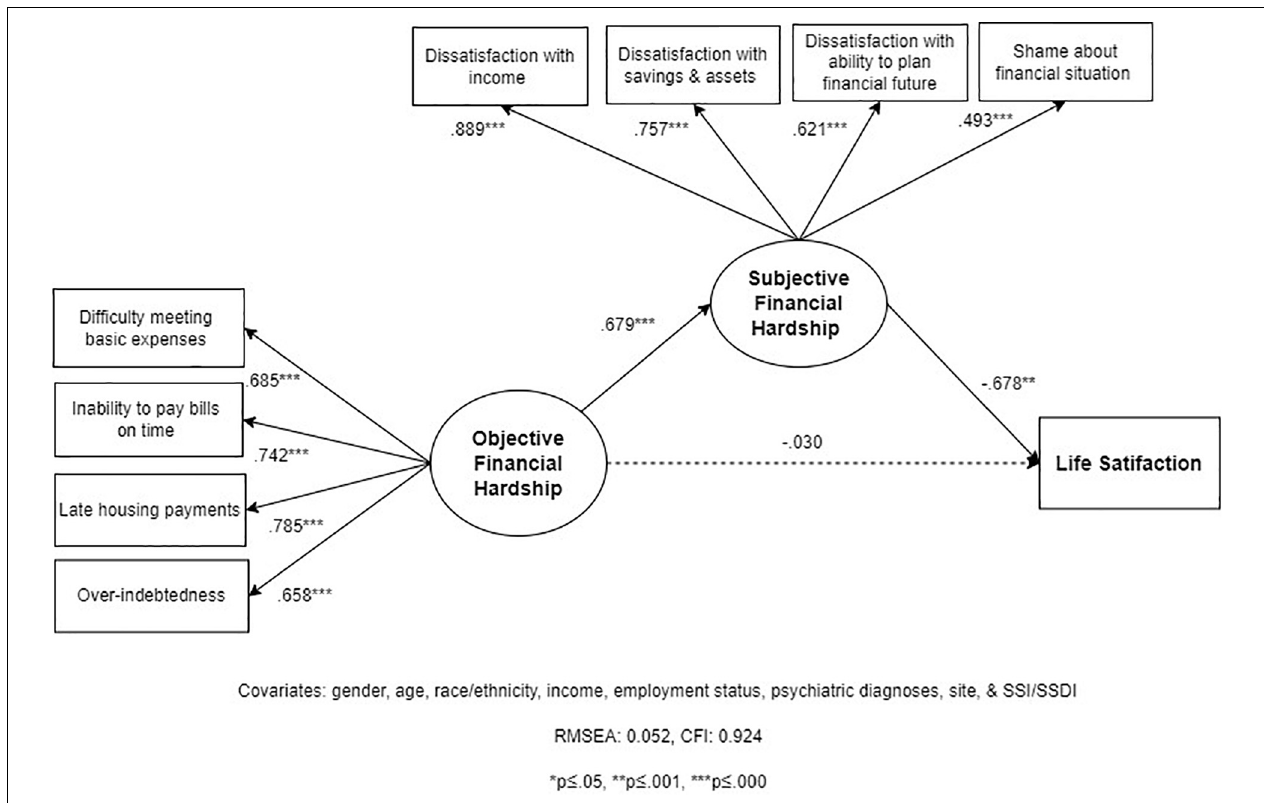
FIGURE 2 | Structural Equation Model 1 (SEM 1): relationships between objective financial hardship (OFH), subjective financial hardship (SFH), and life satisfaction (LS; N =